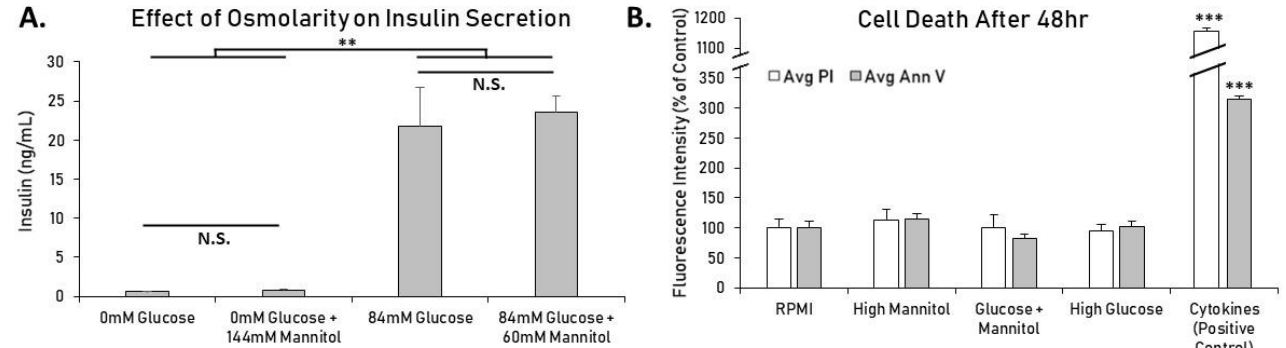
Figure 2. Effects of high glucose and mannitol on mouse islet insulin secretion and cell death. ( A ) Mouse islets were placed in wells containing modified KRB with 0 mM or 84 mM glucose ± mannitol balanced to 144 mM total for 1h. Increasing osmolarity using mannitol did not significantly alter insulin secretion in glucose-free or high-glucose solutions. Twenty islets per condition in duplicate ran in 2 separate trials (N = 4). ( B ) Islets were placed in either standard RPMI, high glucose (144 mM), high mannitol (144 mM), or both glucose (60 mM) and mannitol (84 mM). Islets treated overnight with 5 ng/mL IL-1beta and 10 ng/mL TNF-alpha were used as a positive control to show typical fluorescence levels of induced cell death. Islets in each condition ranged from N = 31–37 after combining two separate trials. All data are presented as mean ± SEM. ** p < 0.01, *** p < 0.001, N.S. = Not Significant.